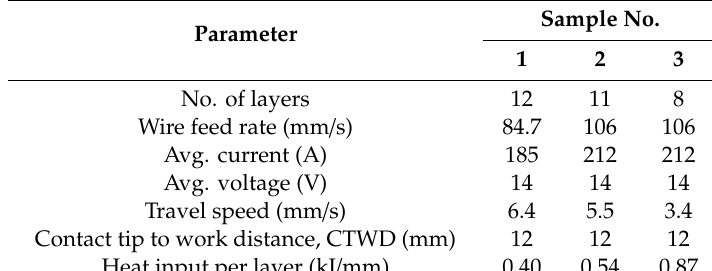
Table 2. Process parameters employed in layer deposition.